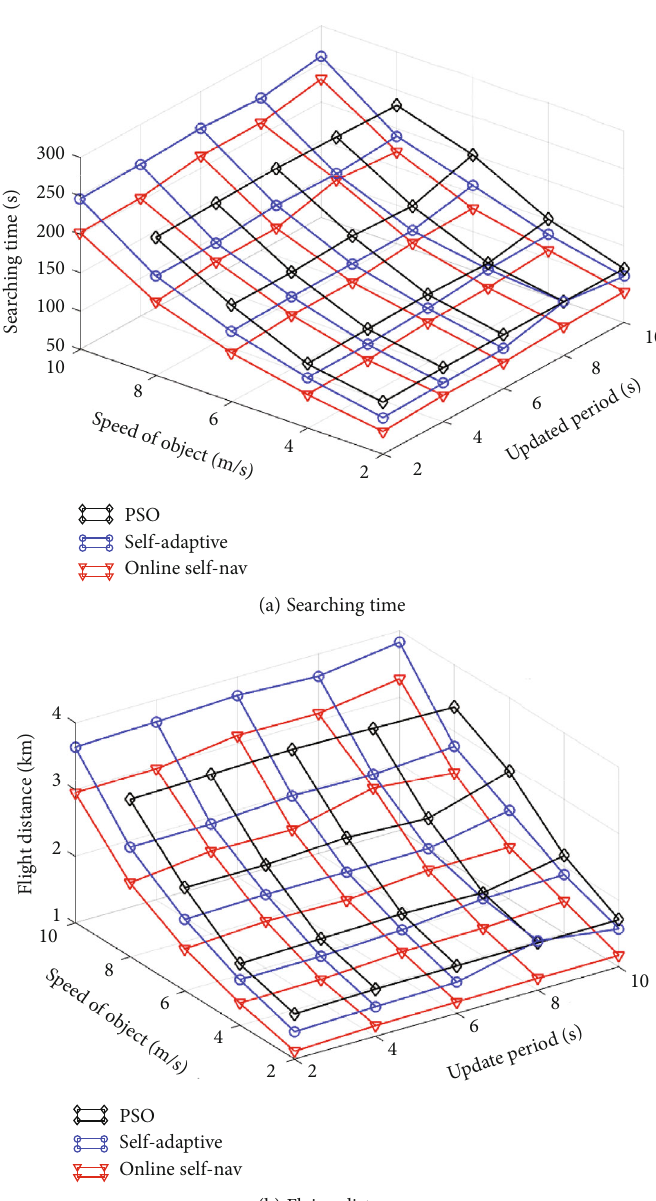
Figure 9: Time and fl ying distance in the online self-navigation, self-adaptive, and PSO strategies before the UAV reaches the object and switches to tracking mode. Our proposed framework is annotated as “ Online self-nav. ” The PSO team did not fi nd out the object at a speed of 10